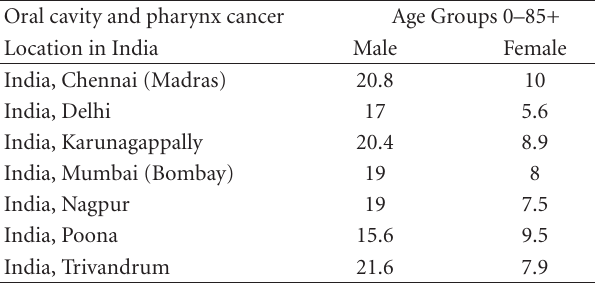
Table 6: Age standardized incidence rates—1998 to 2002. Oral cavity and pharynx cancer